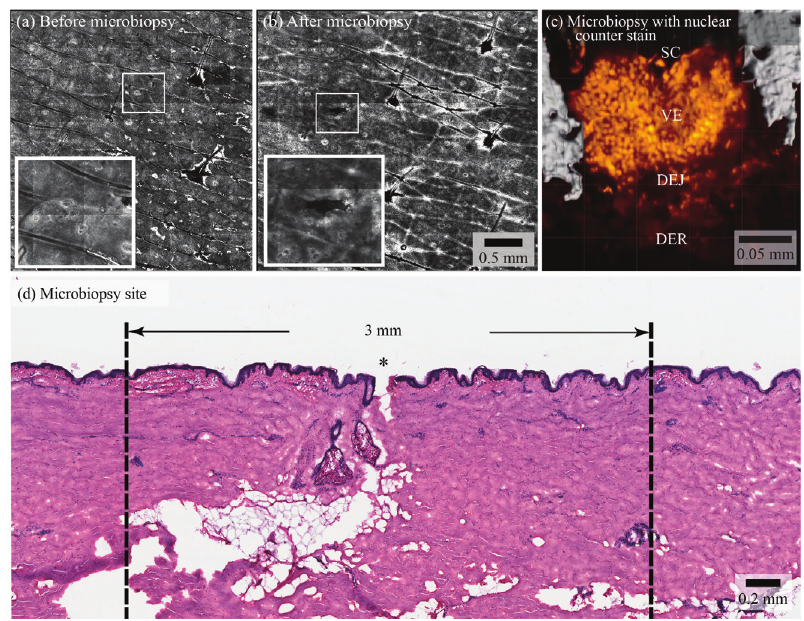
Figure 4. Site of microbiopsy and microbiopsy content. Panels ( a ) and ( b ) are reflectance confocal microscopy mosaics of a microbiopsy site, see the hair follicles featured in the centre and on the right hand side of the images for size comparison (bar indicates 0.5 mm in a and b ). Panel ( c ) shows a 63x magnification, 3D rendering of the microbiopsy tissue with a nuclear counter stain (orange) derived from a confocal microscopy z-stack of the sample within the microbiopsy device. The stratum corneum (SC), viable epidermis (VE), dermal- epidermal junction (DEJ) and superficial dermis (DER) are labeled. This microbiopsy contained an estimated 1634 nuclei. Haematoxylin and eosin stained section of human skin after microbiopsy application shows a 0.10 mm wide and 0.25 mm deep puncture Panel ( d ). * indicates the site of microbiopsy